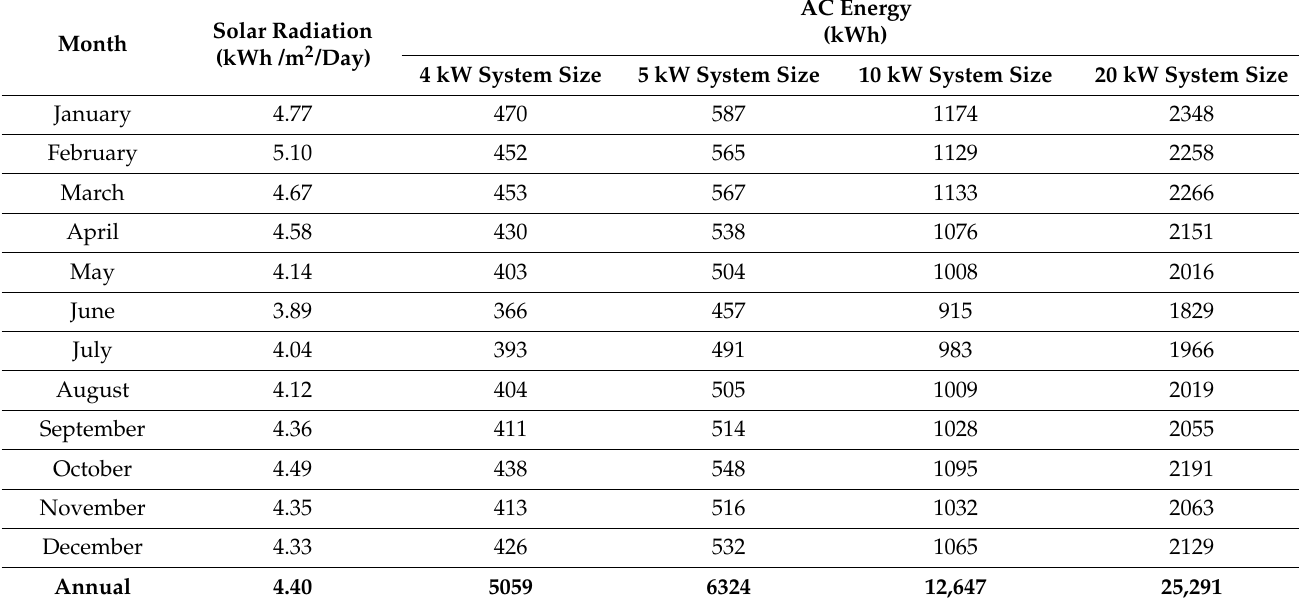
Table 5. Yearly electricity